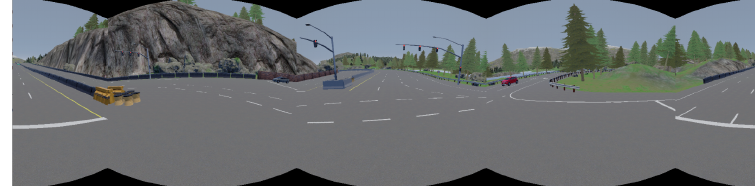
Figure 7. Panorama stitching